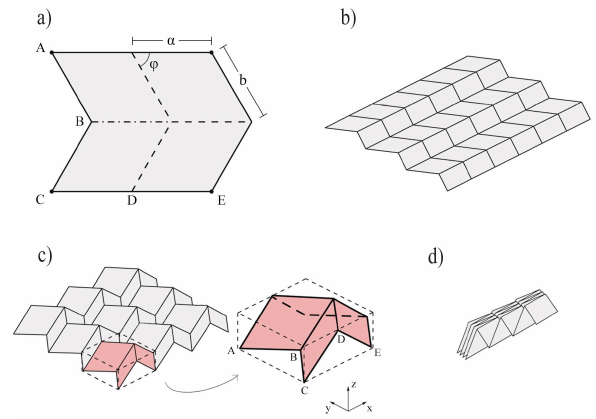
Figure 4: Miura-ori CP: a) unit, b) tessellation, c) half-way folded tessellation and unit detail, d) fully folded